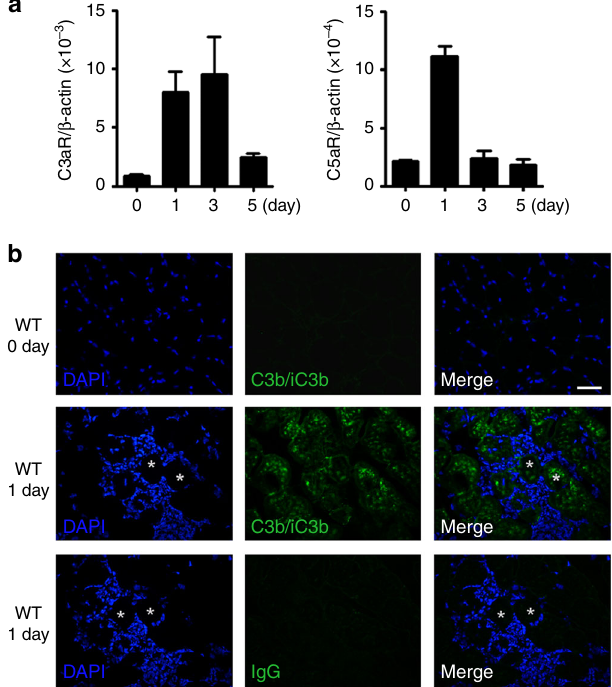
Fig. 1 Complement system was activated after muscle injury. a The mRNA levels of C3aR and C5aR in CTX-injured muscles at day 0, 1, 3, 5 were analyzed by real-time PCR. ( N = 4 in per time point). b Immuno fl uorescence staining of C3b/iC3b (green) in mouse tissues from normal TA muscle and day 1 after CTX-injured TA muscle, and the nuclei were counter stained with DAPI (blue). IgG antibody was used as the negative control. No C3b/iC3b (green) signal was detected in normal muscle. Deposition of C3b/iC3b (green) was detected in the